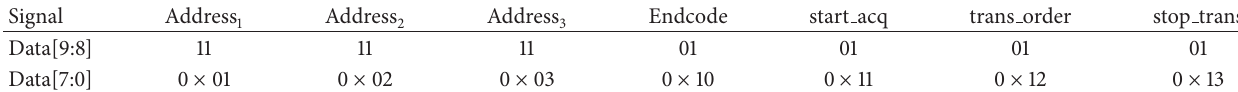
Table 2: Basic control signal.